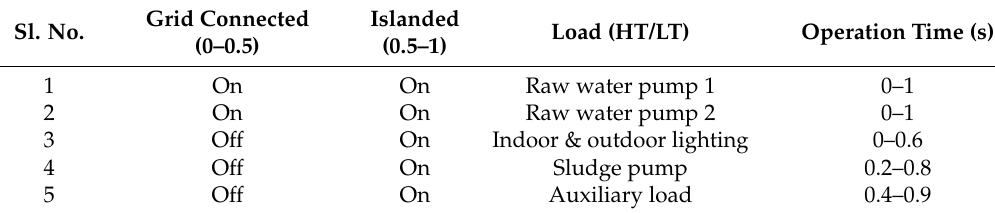
Table 3. Operation timeline of microgrid in grid connected and islanded mode. Sl.